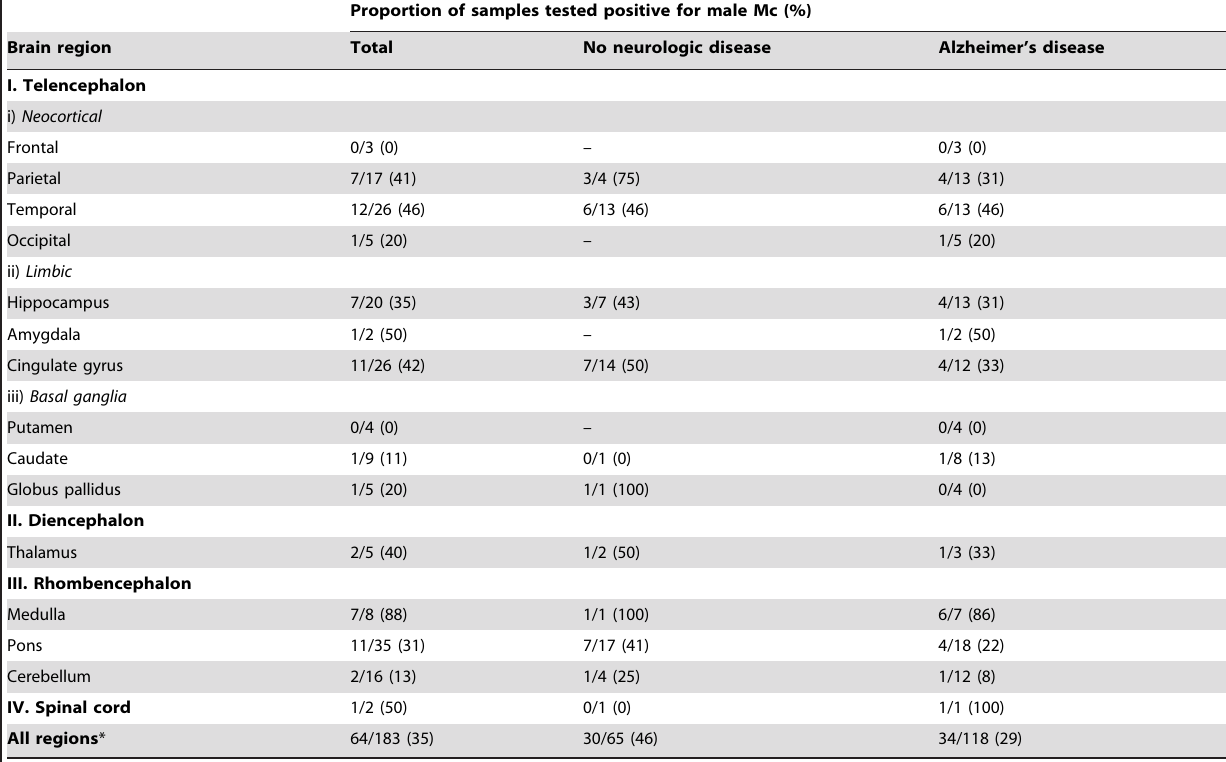
Proportion of samples tested positive for male Mc (%)